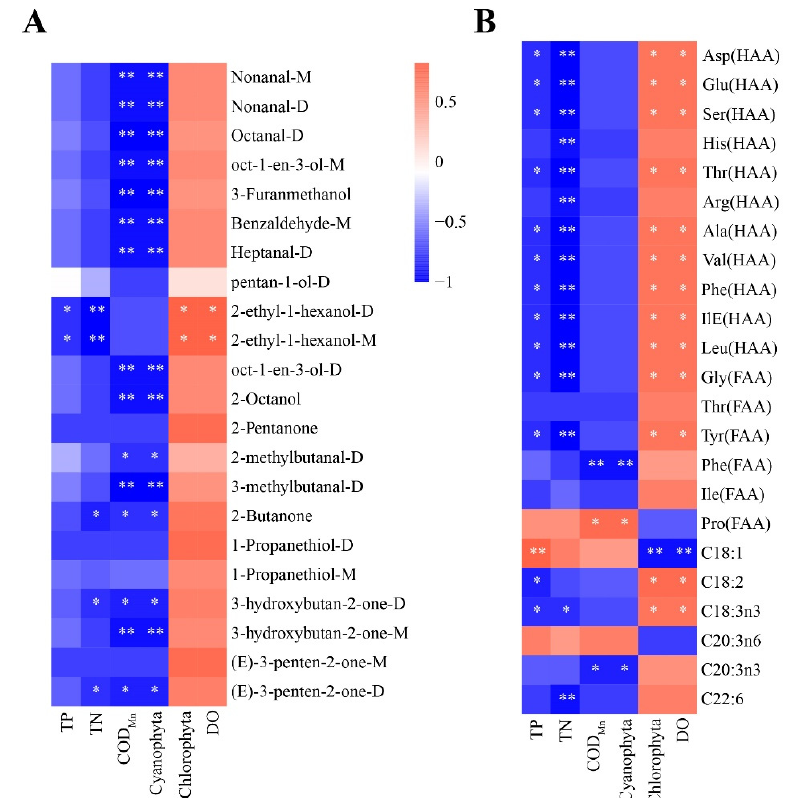
Figure 7. Correlation of significantly different environmental factors with ( A ) volatile compounds and ( B ) nutritional components. Different colors represent the strength of correlation; the red line represents a significant positive correlation, and the blue line represents a significant negative correlation. Note: p < 0.05 indicated significant (*), p < 0.01 indicated highly significant (**).